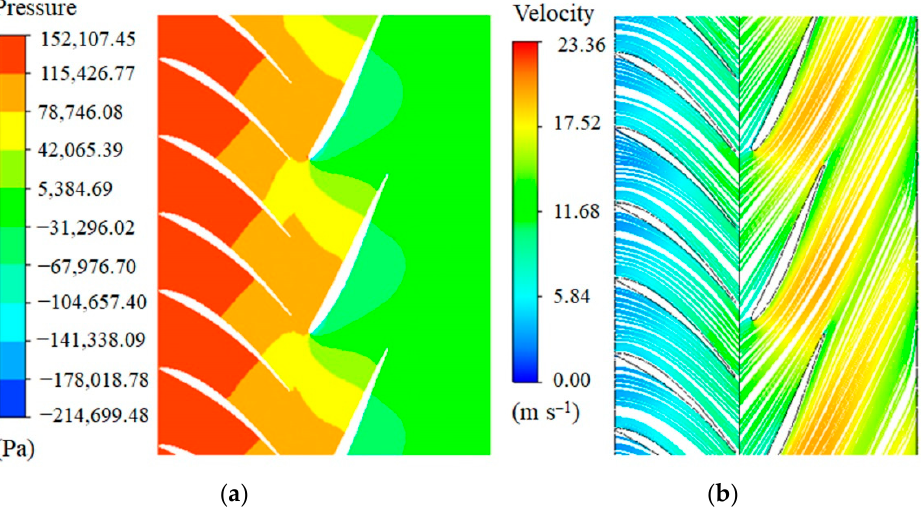
Figure 24. Vane-to-vane pressure and streamline distribution of guide vanes and runner vanes when chords were long: ( a ) pressure distribution; ( b ) streamline distribution. Table 9. Performance characteristics according to guide vane shape (long chord, H = 14.84 m).